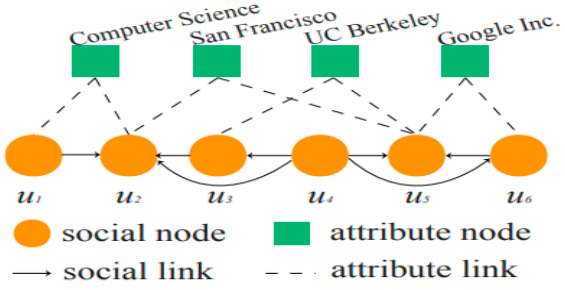
Figure 36. Social attribute network (SAN) with six users and four attributes.